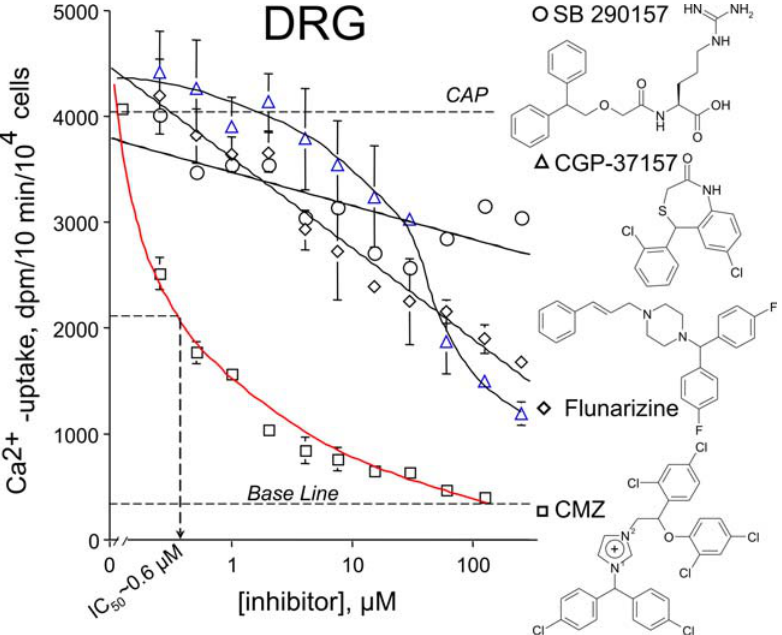
Figure 6. Efficacy of Ca 2 + - calmodulin inhibitors in rat primary DRG cultures. Neuron cultures derived from embryonic rat DRGs readily show inducible (10 fold over base line) activation with vanilloids due to endogenous expression of TRPV1. As with the TRPV1-NIH 3T3 cells, calmidazolium was determined the most effective inhibitor of capsaicin-induced Ca 2 + -uptake. As controls of specificity, flunarizine, SB 290157, and CGP 37157 showed only partial blocking activity in DRG neurons. Similar results were obtained in two additional experiments carried out in